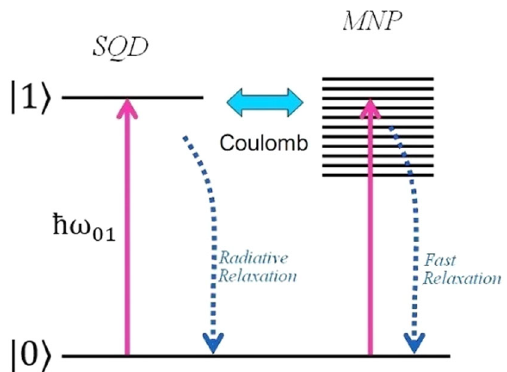
Figure 2, with its ground state | 0 (cid:105) and its excited state |1 〉 , respectively, and the probe field is nearly resonant with the |0 〉 → |1 〉 interband transition.